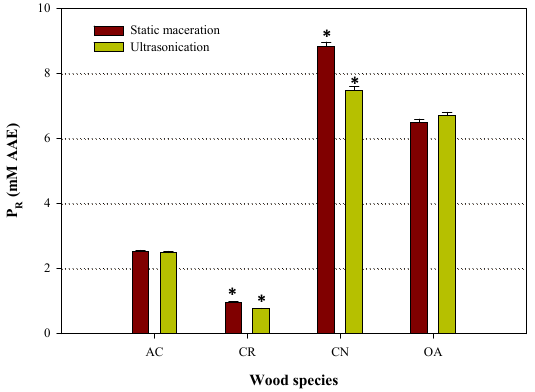
Figure 2. Comparative diagram showing P R of Tsipouro samples, aged with wooden chips under SM and US. Asterisk denotes statistically different values ( p <